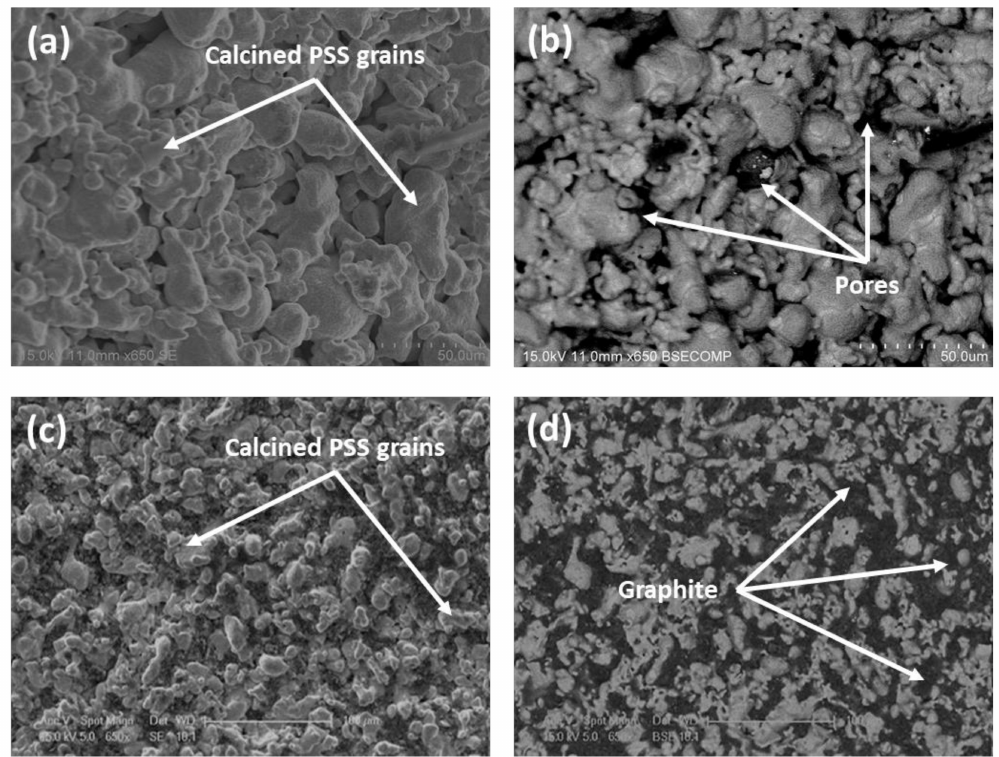
Figure 2. Top-view SEM images of commercial porous stainless steel (PSS) support after modification by calcination in air at 600 ◦ C for 12 h ( a , b ) and incorporation of graphite lead particles ( c , d